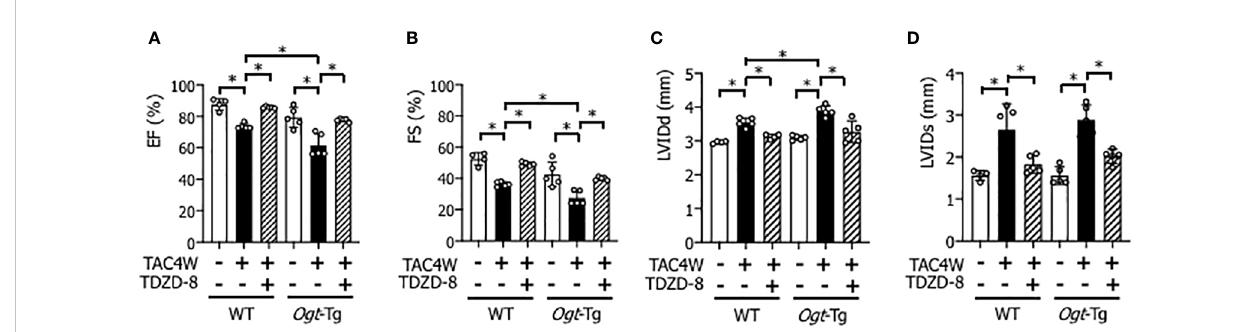
FIGURE 5 Restoration of cardiac dysfunction and enlargement by the treatment of TDZD-8 in WT and Ogt-Tg mice after TAC4W. Echocardiographic analysis of (A) Ejection fraction (EF), (B) Fractional shortening (FS), (C) left ventricular (LV) end-diastolic dimension (LVIDd), (D) end-systolic LV internal dimension (LVIDs) in TAC4W-treated WT and Ogt-Tg mice. The data were evaluated by two-way analysis of variance (ANOVA) followed by Tukey ’ s test. Values are shown as mean ± SD (n=4). *P<0.05. TAC, transverse aortic